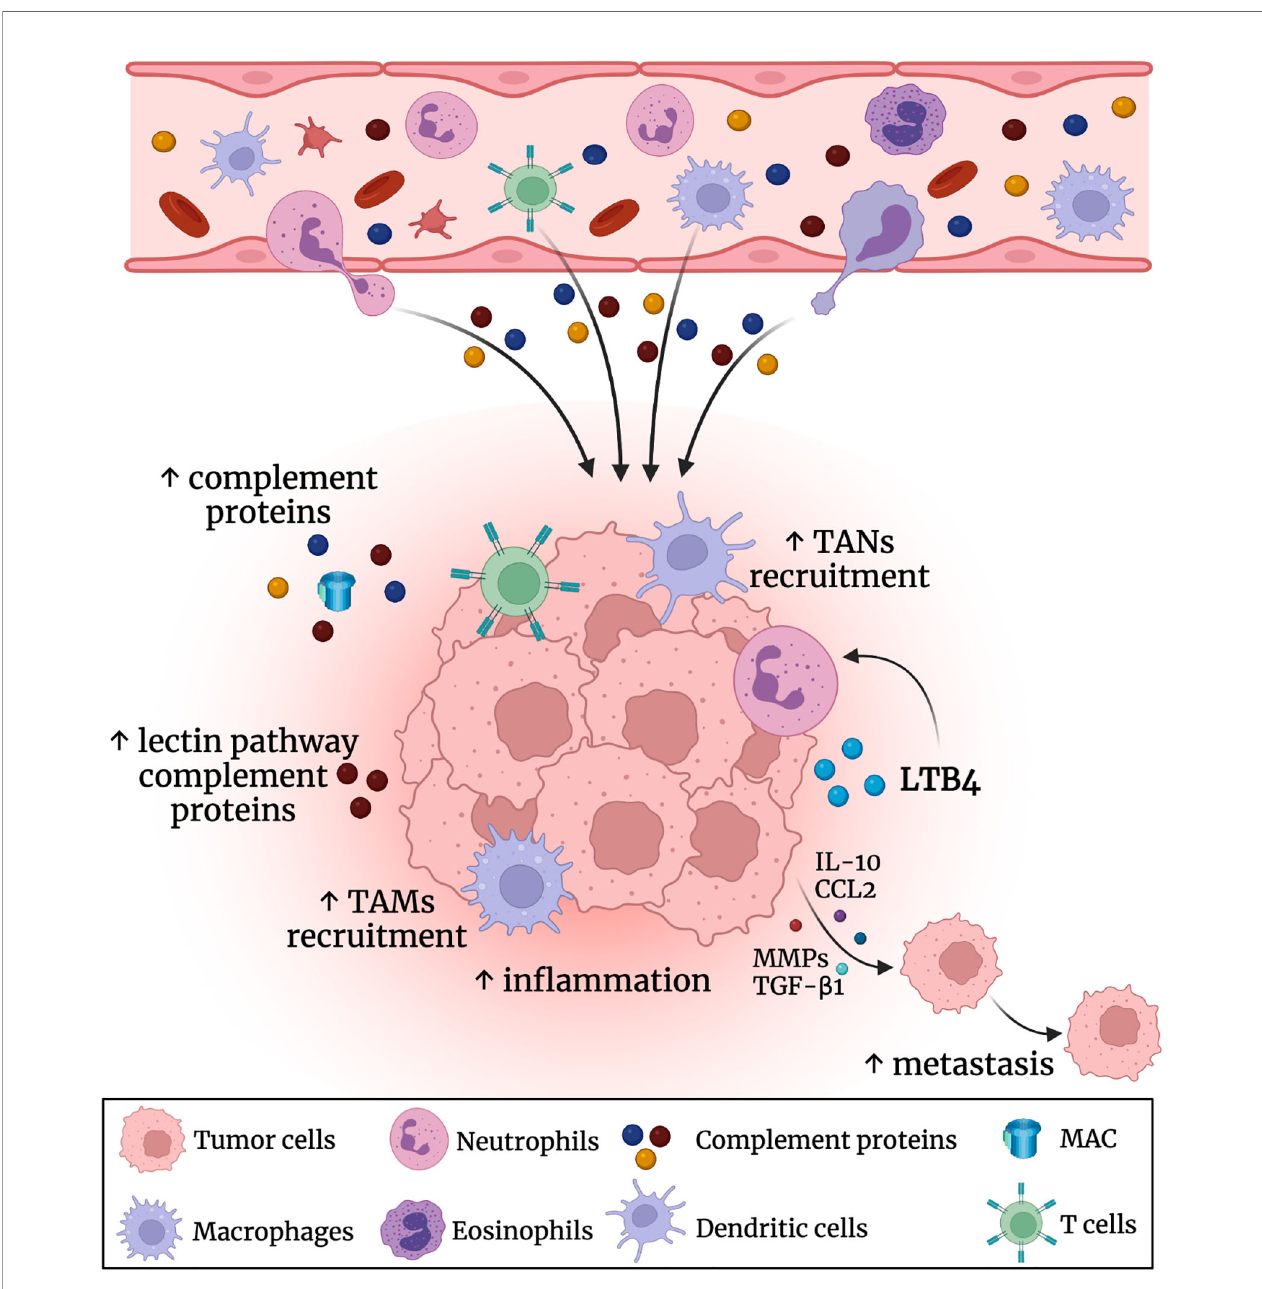
FIGURE 2 | Role of the complement system in the CRC tumor microenvironment (TME). Complement proteins are produced by the liver into the circulatory bloodstream. There was an elevation in the levels of the complement proteins (especially the leptin pathway related proteins) in the colon TME. This promotes further in fl ammation and recruitment of tumor associated macrophages (TAMs) and tumor associated neutrophils (TANs). Also, the complement system triggers the secretion of IL-10, CCL2, TGF- b 1 and metalloproteinases (MMPs) that could enhance CRC